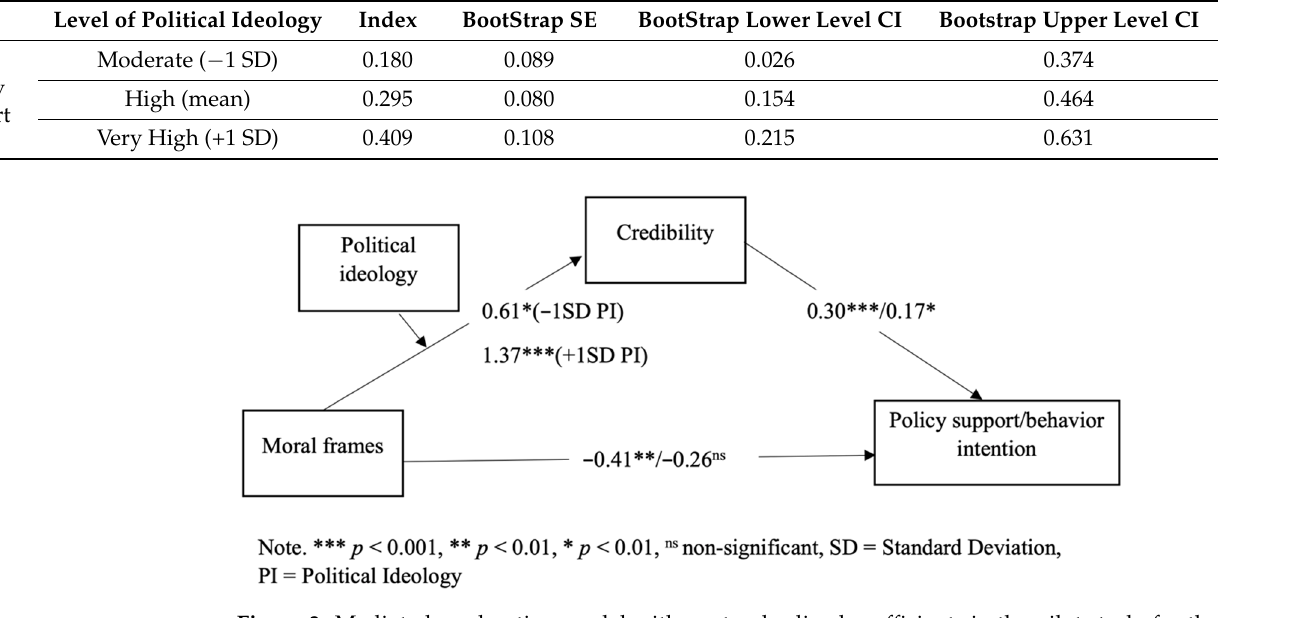
Figure 3. Mediated moderation model with unstandardized coefficients in the pilot study for the policy support variable.